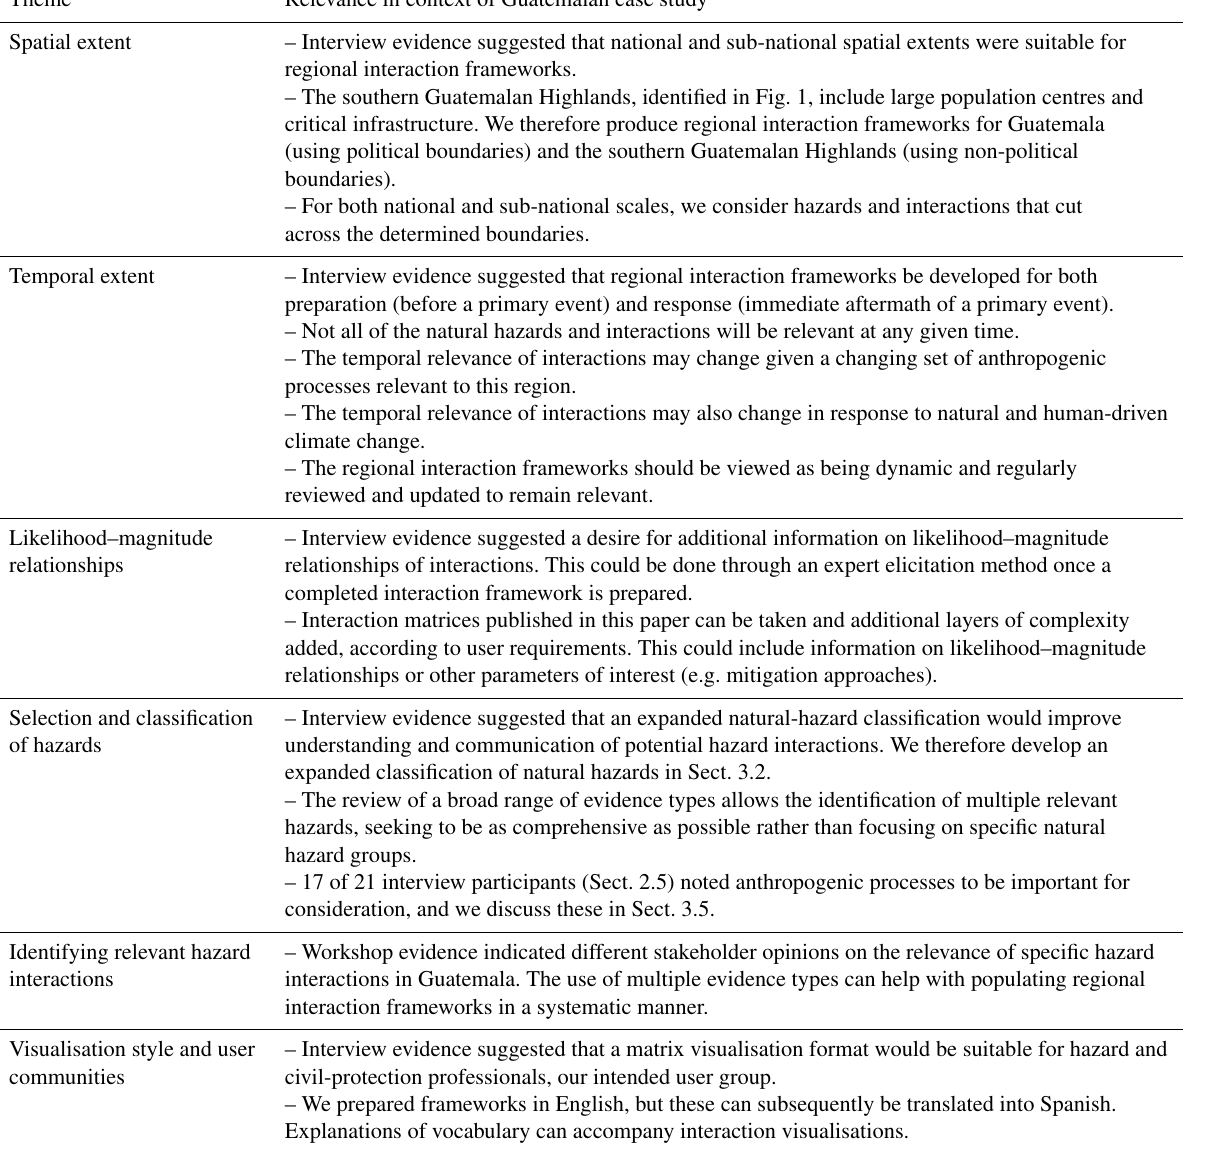
Table 3. Consideration of six regional hazard interaction themes (identified in Gill, 2016) with respect to Guatemala. A description is given of how each theme is addressed in this regional interaction framework, using stakeholder comments discussed in Sect. 2.5 (interviews) and Sect. 2.6 (workshop results) to inform this